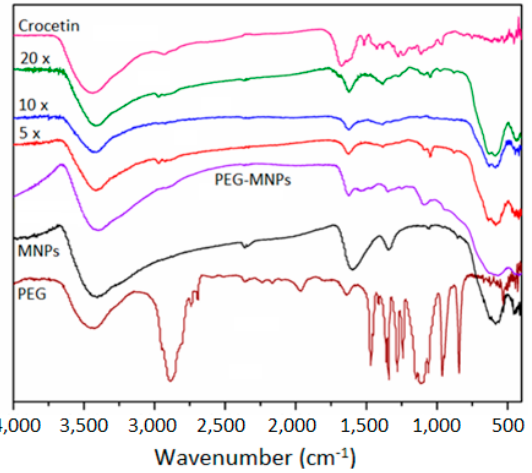
Figure 5. FT-IR spectra of the crocetin-functionalized PEG-coated MNPs as a function of the con- centration of crocetin .